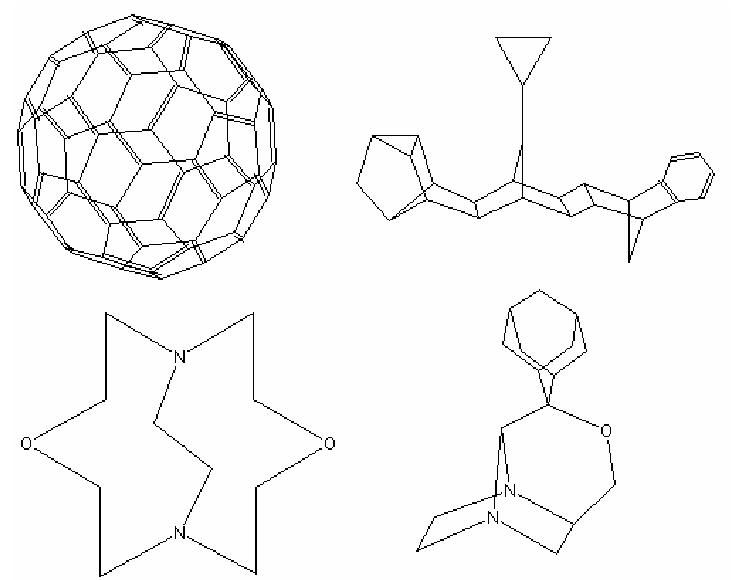
Figure 4. Examples of structure diagrams generated from MCDL